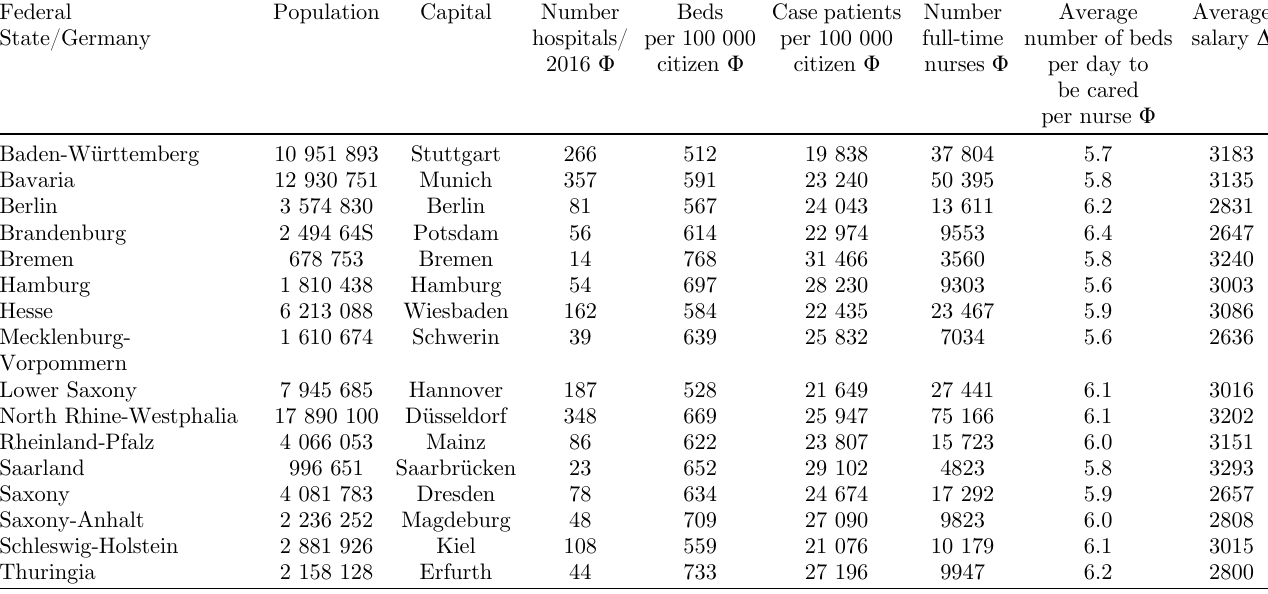
Table 1. German Federal States with population, capital, and number of